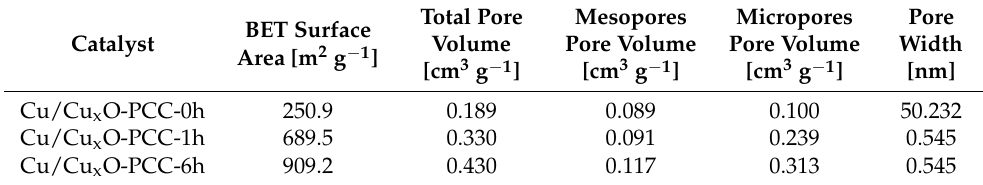
Table 1. BET surface area and pore volume of the three catalysts.